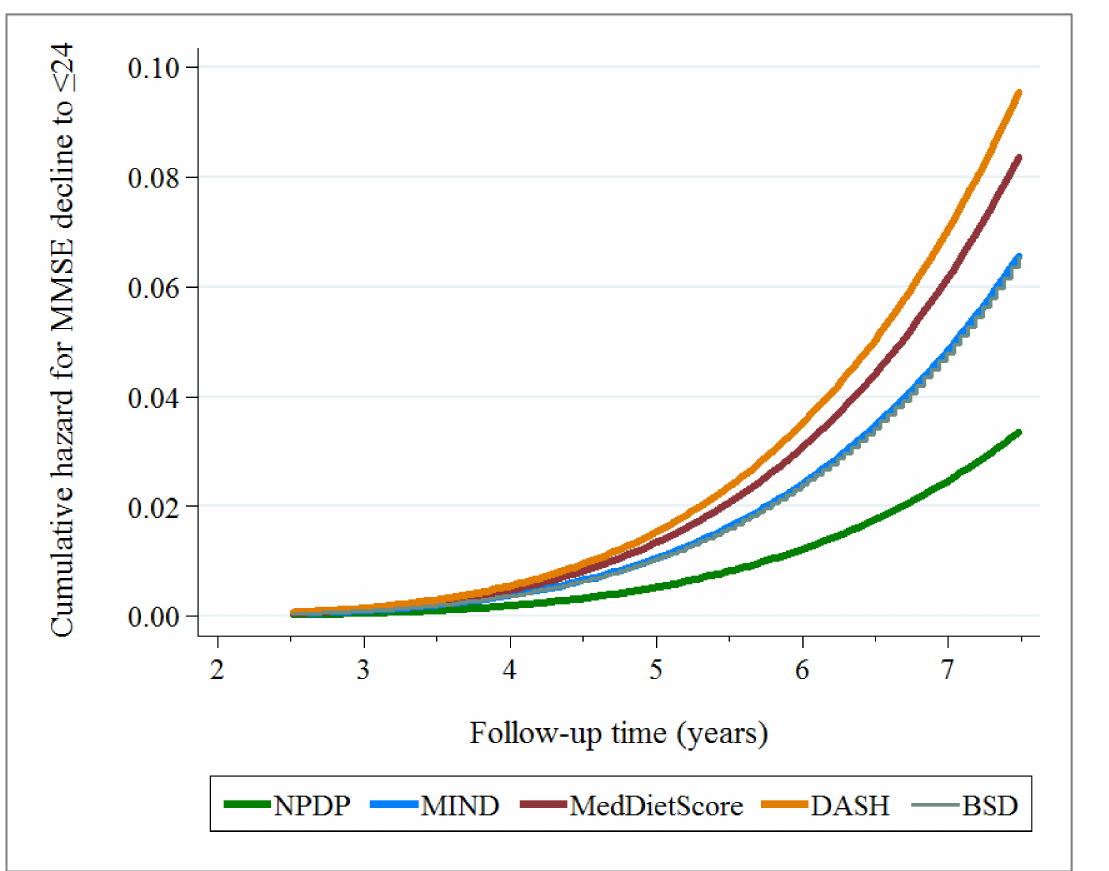
Figure 1. Cumulative hazard function curve (stcurve command in Stata) plotted after running the parametric survival models (Supplementary Table S4) for each dietary index in relation to MMSE decline to ≤ 24 over 6 years. Each model was adjusted for total calorie intake, age, sex, education, civil status, physical activity, smoking, body mass index, vitamin/mineral supplement intake, vascular disorders, diabetes, cancer, depression, APOE ε 4, and dietary components other than those included in each dietary